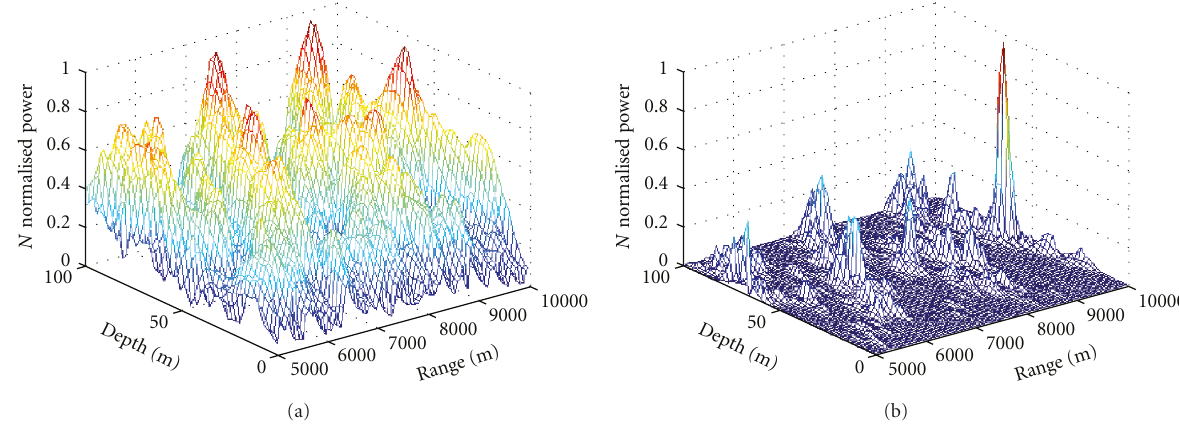
Figure 3: Bartlett ambiguity surface (a) and EMD-MFP ambiguity surface (b) for COLNOISE ( − 5 dB SNR case).